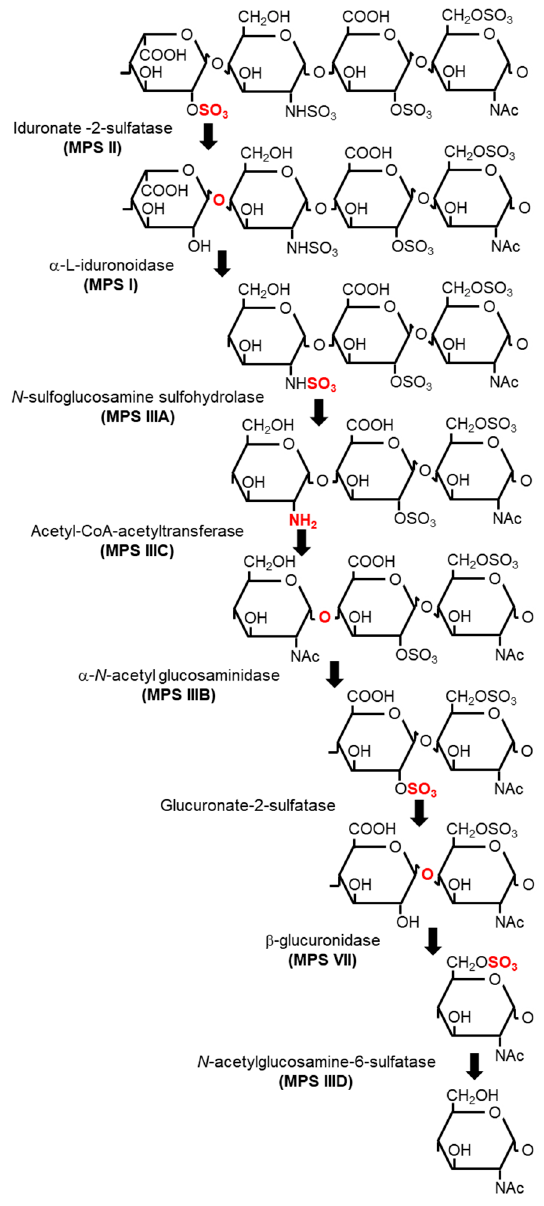
Figure 2. Sequential degradation of heparan sulfate (HS) and the catalyzing enzyme in each reaction. The type of mucopolysaccharidosis (MPS) caused by genetic defects is indicated in parentheses under the corresponding enzyme.